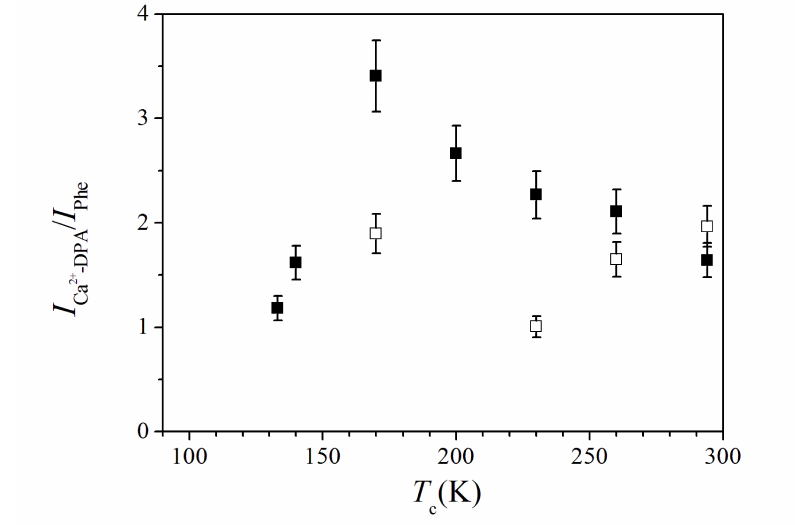
Figure 6. Temperature dependence of I Ca 2 + − DPA / I phe intensity ratio of spores after the cooling process at